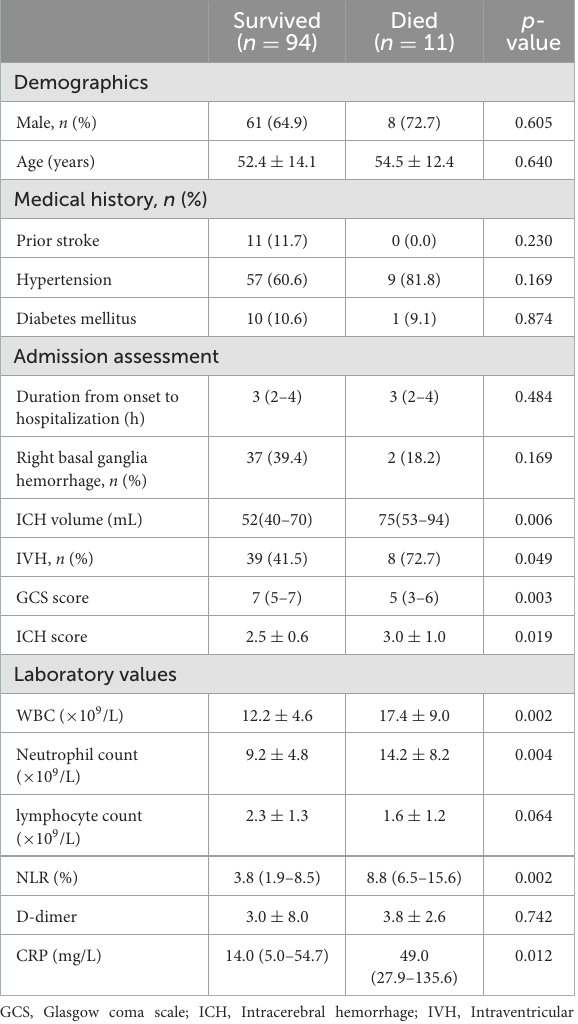
TABLE 1 Baseline characteristics of patients according to 30-day outcome.